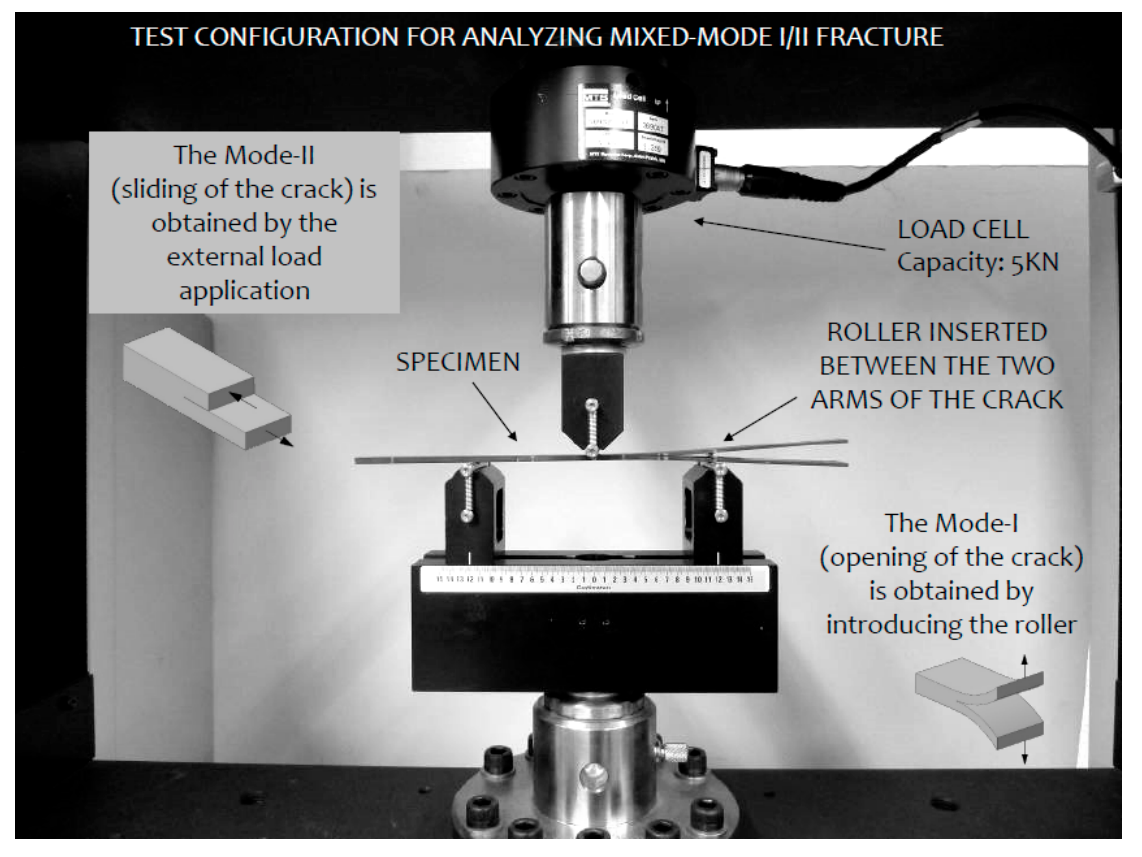
Figure 6. Lay out of the test. Specimen positioned in the test rig.